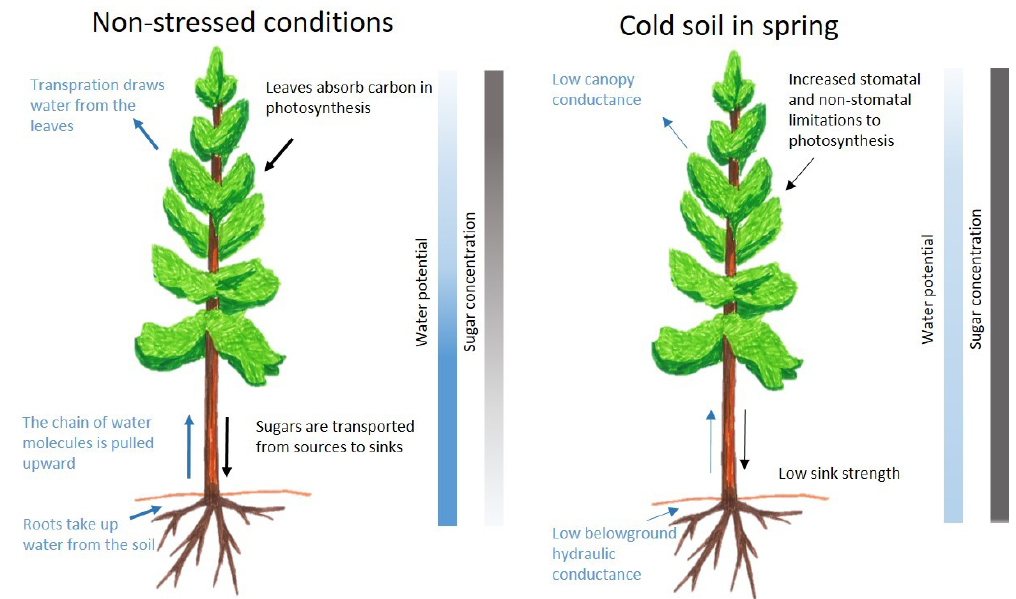
Figure 1. A recent field and modelling study shows that cold soil decreases below-ground hydraulic conductance (i.e. less root water uptake) and further canopy conductance in mature, boreal trees in spring (Lintunen et al., 2020). Cold temperature also decreases sink strength (i.e. fewer sugars are needed for metabolism and growth). Low sink strength increases sugar concentration in leaves, which decreases photosynthesis due to increased stomatal and non-stomatal limitations for photosynthesis (Hölttä et al., 2017; Salmon et al.,